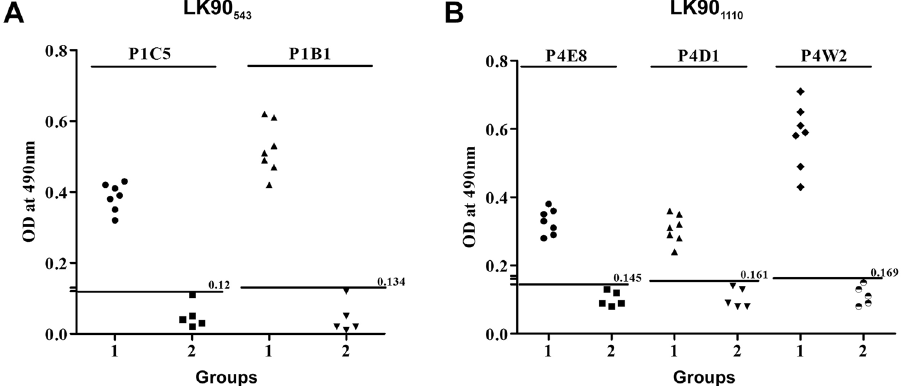
Figure 2. Specificity of the monoclonal antibodies for detection of leptospiral serovars. Heat extracted proteins from MACS leptospiral strains or non- Leptospira bacterial pathogens were used as antigens in IgG ELISA. Specificity of the MAbs produced from the hybridoma clones of LK90 543 ( A ) and LK90 1110 ( B ) are shown. Study groups: Group 1- Different leptospiral serovars; Group 2- Non- Leptospira bacterial pathogens. The line represents the cut-off as determined by Mean + 2 SD of the OD values of other bacterial pathogens, with the absolute values on the right. Study groups are indicated on the x axis and the optical density (OD) at 490 nm on the y axis.